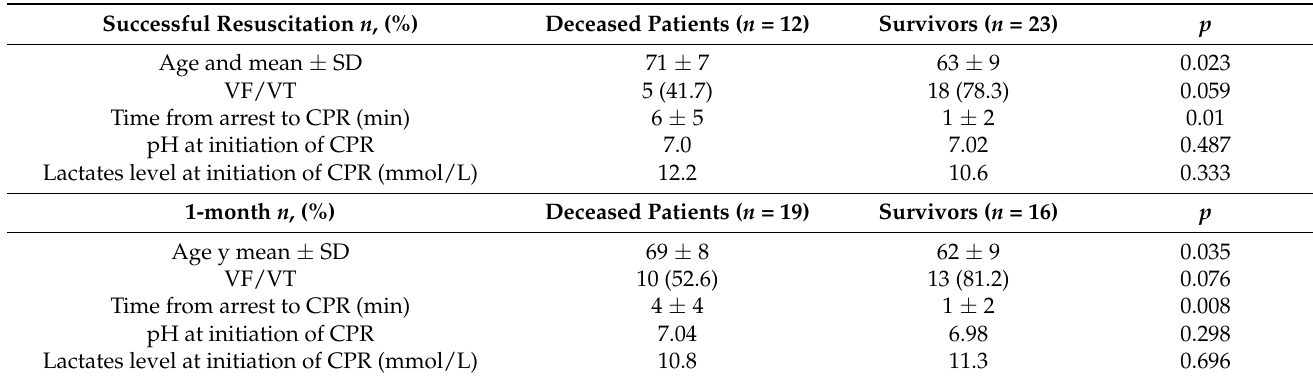
Table 2. Univariate predictors of survival.